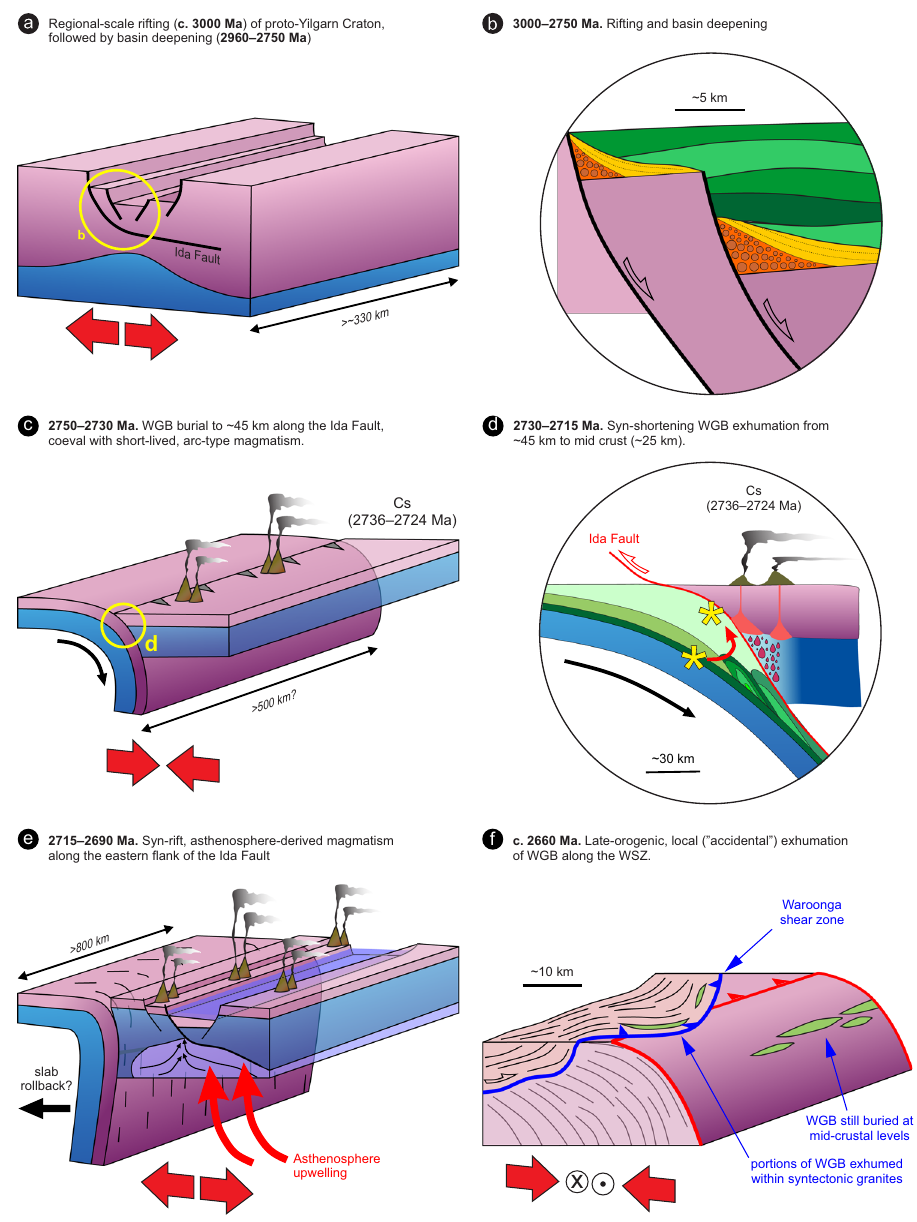
Fig.9|TectonicevolutionofthecentralportionoftheYilgarnCraton. Meso-to Neoarchean tectonic evolution of the central portion of the Yilgarn Craton, with emphasis on the along-strike structural continuity. a C. 3000Ma, regional-scale rifting occurred in the central part of the Yilgarn Craton. The minimum size of the rift-related structures isinferredby the current along-strike exposure(~330km) of the syn-rift quartzite (Fig. 1a). b Detail from a showing the syn-rift deposition of conglomerate (orange) and quartzite (yellow) at c. 3000Ma, followed by the 2960 – 2750Ma post-rift, deep-marine sequence (green), of prevailing basalt and Banded Iron Formation (BIF). c 2750 – 2730Ma burial of the eastern margin of the Youanmi Terrane under the Eastern Gold fi elds Superterrane (EGST). The current extension of the Ida Fault (~500km) suggests that the buried margin extended for